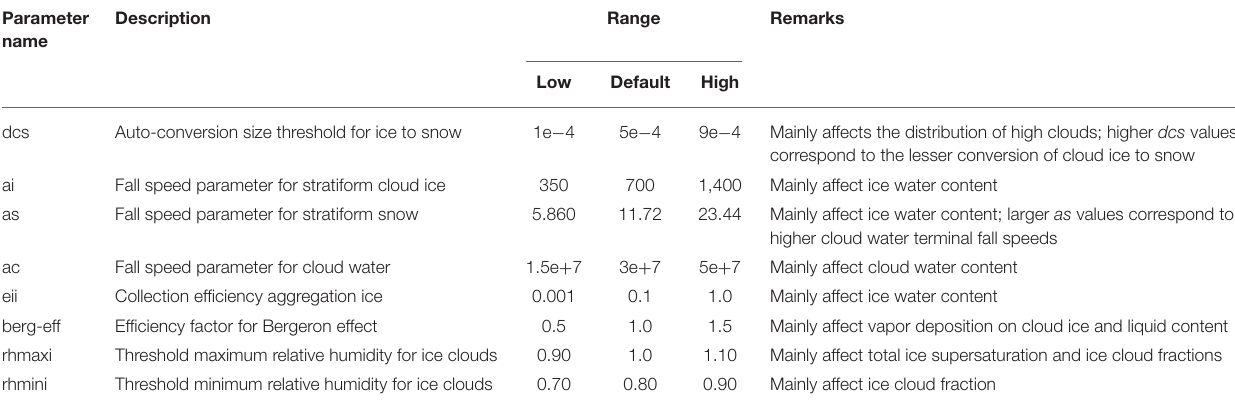
TABLE 1 | Cloud microphysics and macrophysics parameters used in this